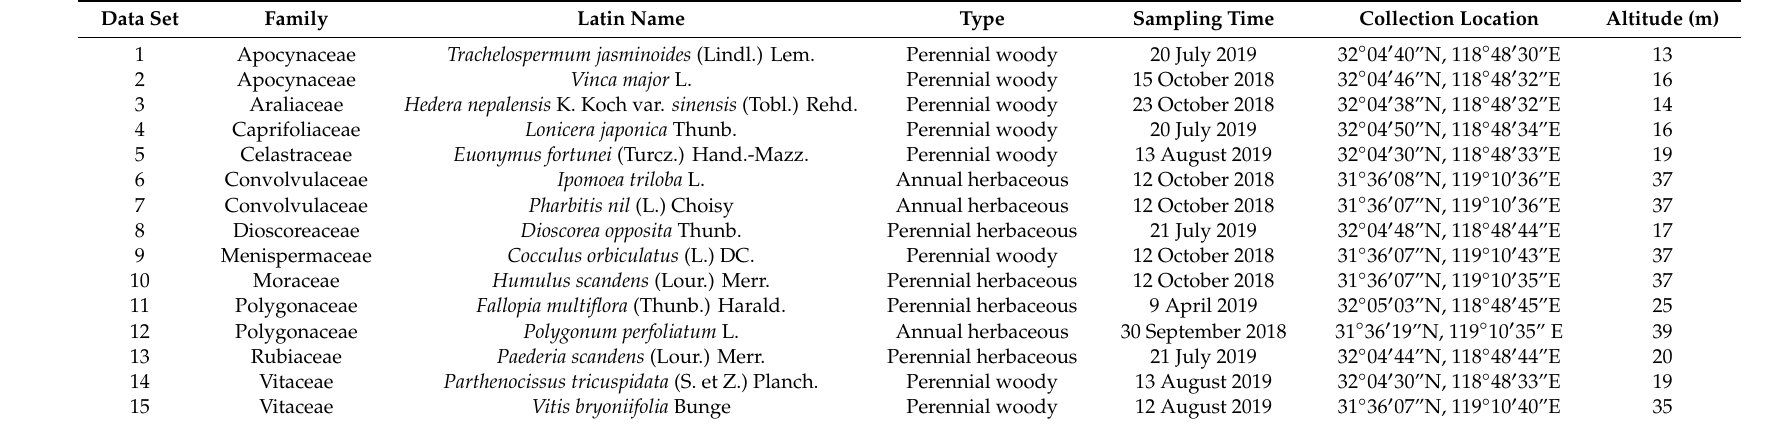
Table 1. Leaf collection information of 15 species of climbing